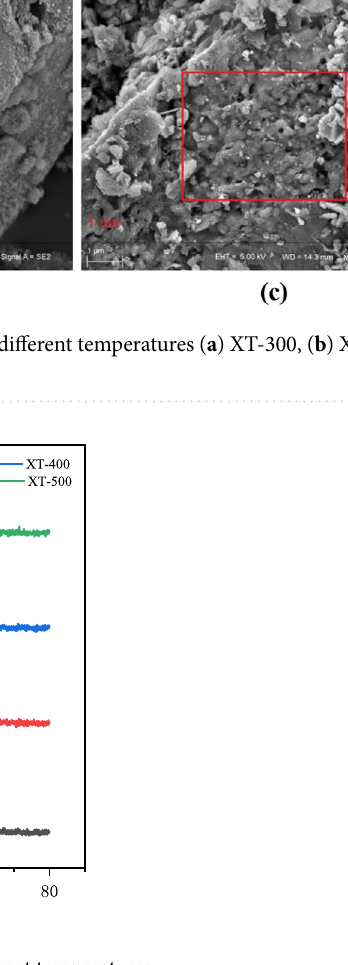
Figure 9. X-ray diffraction patterns of adsorbents at different